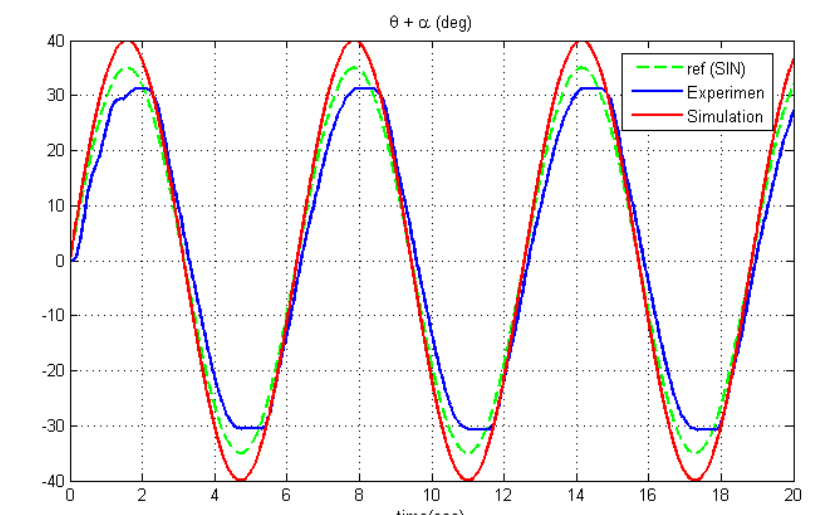
Figure 11. Controller response for